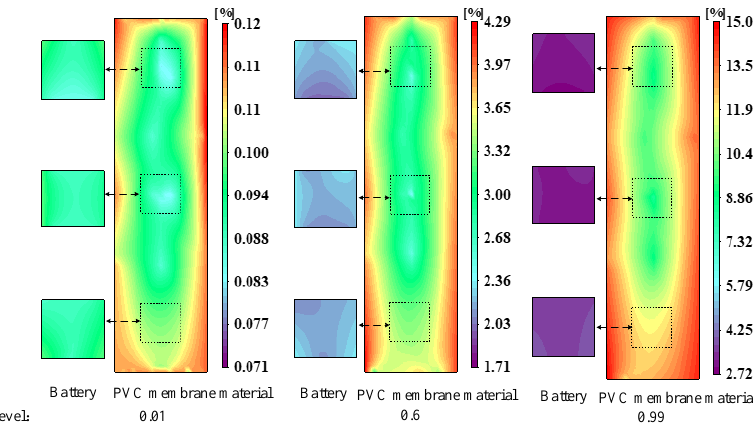
Figure 6. Strain cloud maps of thin-film cells and PVC films at different load levels.